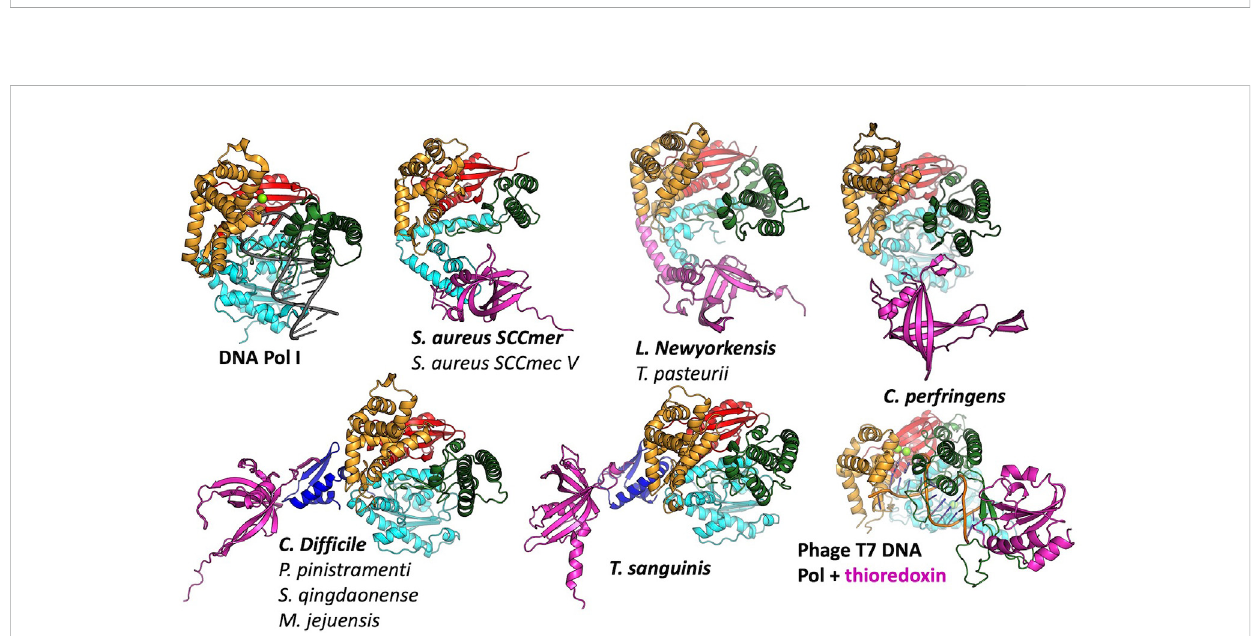
FIGURE 4 Predicted modes of Pol-SSB interactions. Models are colored as in Figure 2, with putative SSBs in pink. They were aligned according to their palm domains, except for T7 DNA polymerase, which was aligned to the C. perfringens model using the thumbs as guides. DNA Pol l (1l5u.pdb; Johnson et